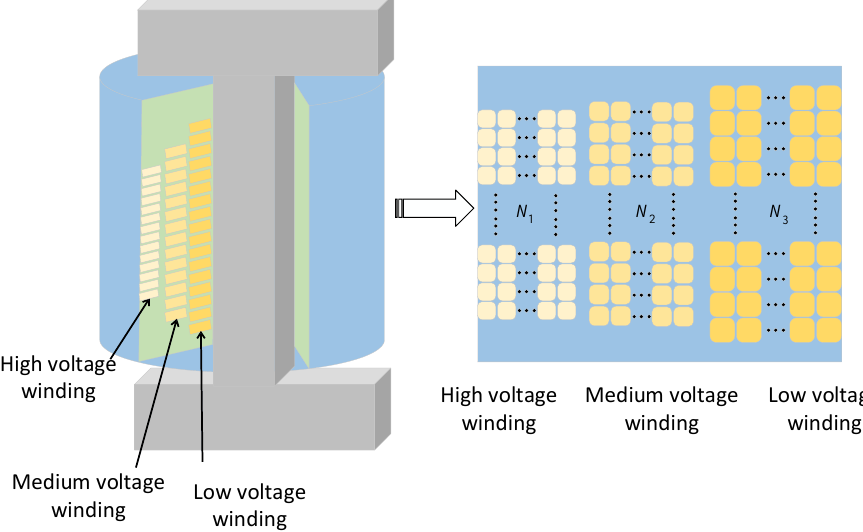
Figure 2. Transformer axial section model.